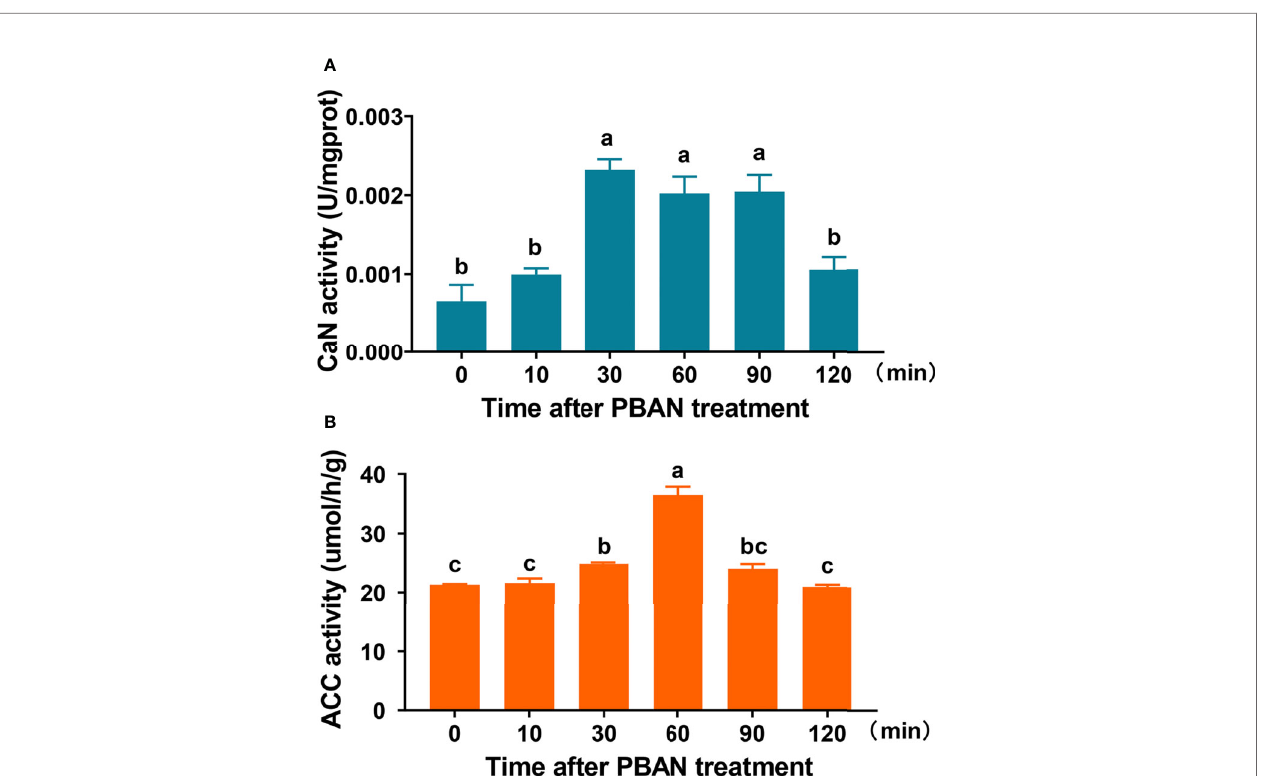
FIGURE 3 | PBAN regulated CaN and ACC activity in O. furnacalis PGs. (A, B) The activity of CaN and ACC after PBAN incubation in O. furnacalis PGs. Data represent the mean ± SE (n = 3). A multiple comparison test with P < 0.05 was conducted to test the signi fi cant differences in different development time points (based on Tukey ’ s test, DPS7.05). NS, not signi fi cant. Small letters a-c indicate signi fi cant